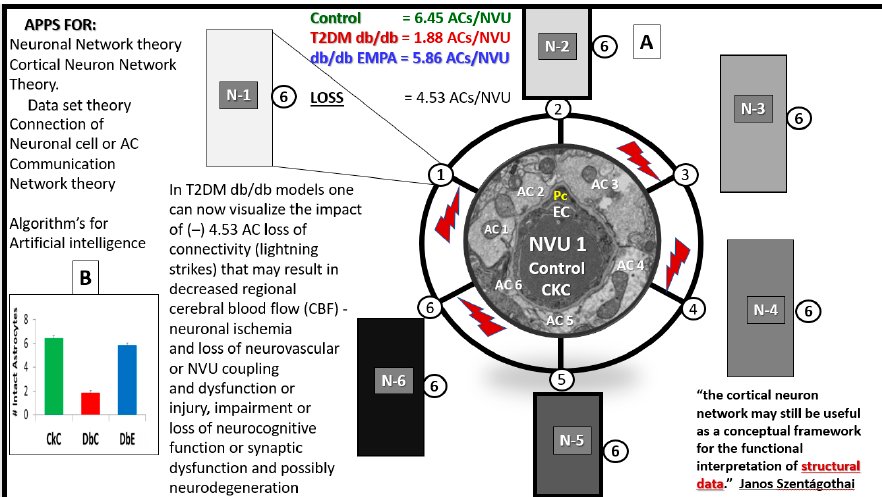
Figure 6. The possible mechanisms involved regarding the six degrees of separation between regional neurons and the loss of astrocyte foot processes hypothesis in diabetes: Having quantified the loss of four ACfp / NVU in the diabetic DBC as compared to CKC and DBE, one can now better envision the potential impact on regional neuron dysfunction and how that might affect extremely large numbers of connecting interneurons. The NVU is placed centrally and illustrates 6 ACfp that connect to possibly 6 connection points of regional neurons that, in turn, may connect to 6 other interneurons ( A ). This figure may allow one to better envision the potential devastating effects of just how vast the connections are within the mammalian brain and especially in humans with such a vast expansion of the neocortical synapses (approx. 0.15 quadrillion) (Figure 6A). The loss of four ACfp / NVU in the DBC is represented by red lightning strikes, and the bar graph demonstrates the loss of ACfp / NVU in the DBC ( B ). This hypothetical figure also adds to the currently well-accepted concept that a typical neuron receives on the order of 10,000 synaptic contacts. ACfp = astrocyte foot processes; APPS = applications; T2DM = type 2 diabetes mellitus; N = neuron; NVU = neurovascular unit. Available via license CC BY